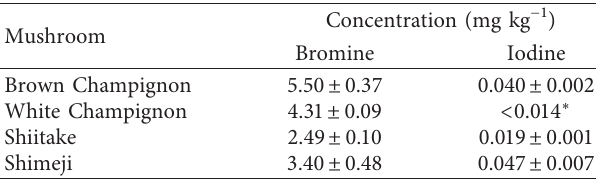
Table 4: Concentration of bromine and iodine in mushrooms (dry base; 500mg) after digestion by the MIC method using